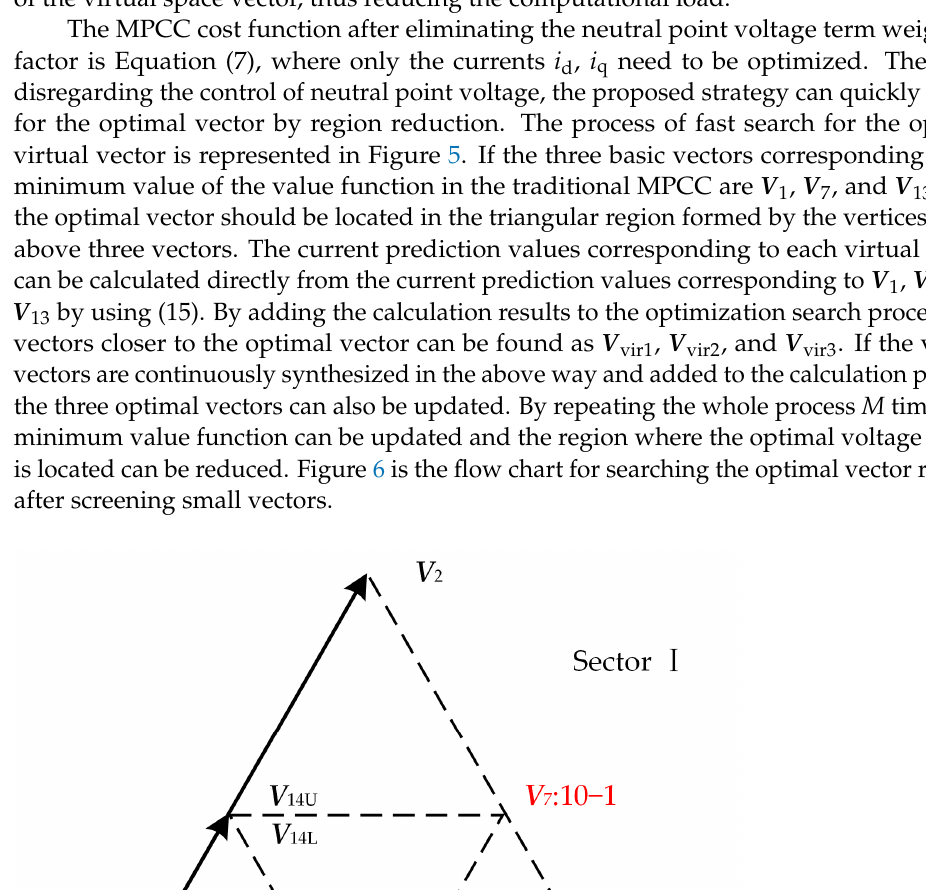
Figure 5. Diagram of optimal vector search ( M = 2).